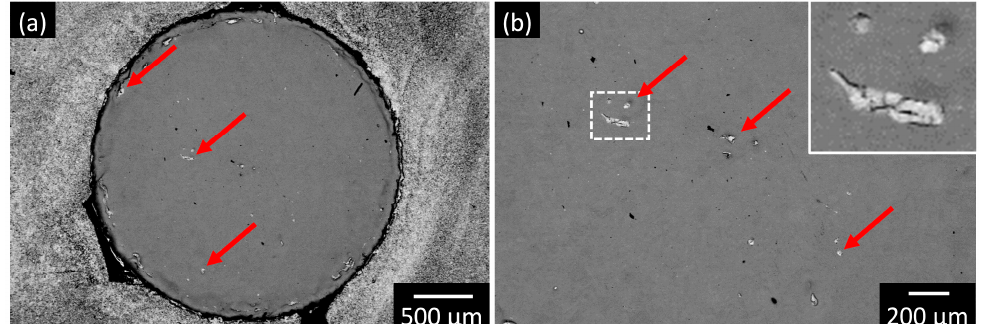
Figure 5. SEM micrographs for the 316L/CeO 2 composite synthesized by SLM at 488 mm/s: ( a ) overview showing the distribution of the CeO 2 particles; ( b ) view at higher magnification revealing that clustering of the CeO 2 particles occurs during SLM (see also the inset corresponding to the dashed box in ( b )). The red arrows indicate the position of the CeO 2 particles.